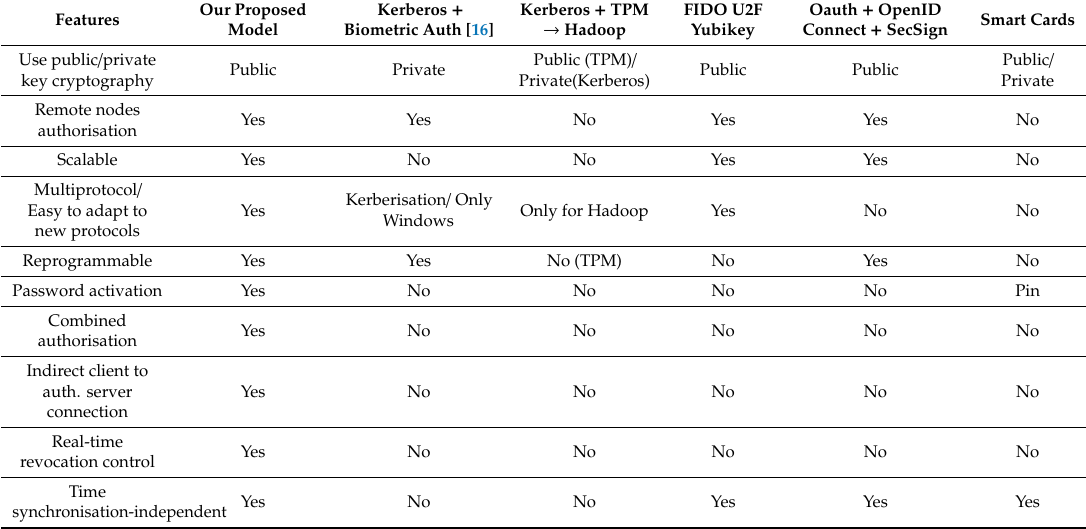
Table 1. Comparation of main features among di ff erent authentication